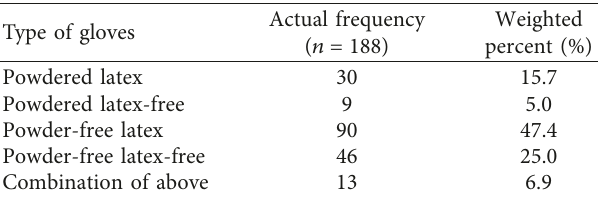
Table 7: Type of gloves used by respondents.